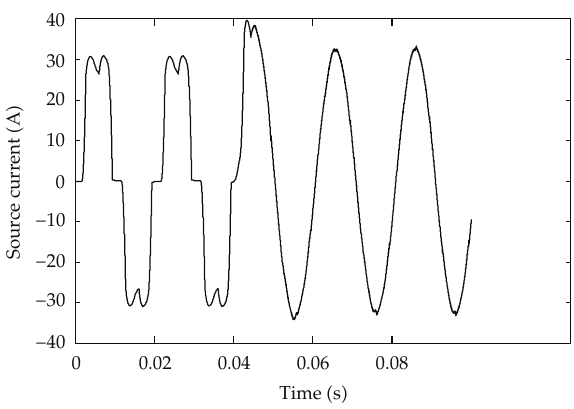
Figure 3: A phase source current.